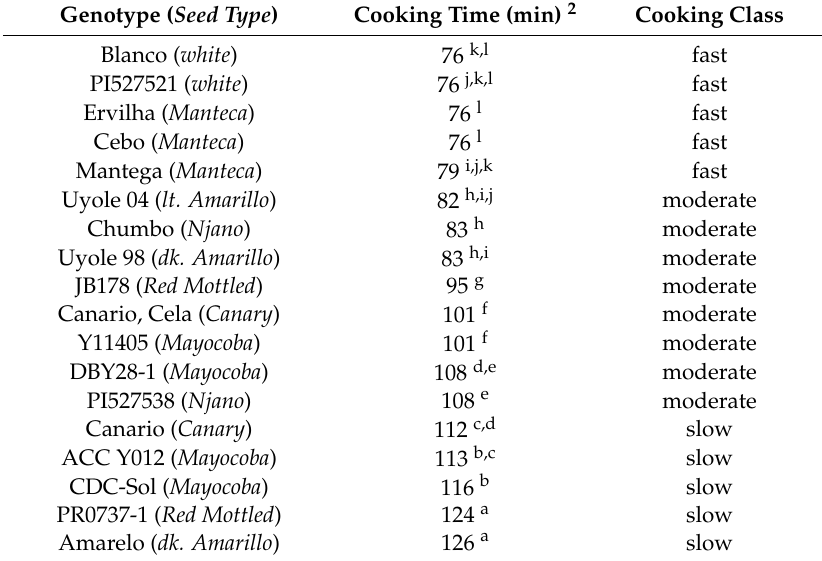
Table 3. Cooking Times of Unsoaked Genotypes in the Yellow Bean Panel 1 . Genotype ( Seed Type ) Cooking Time (min)